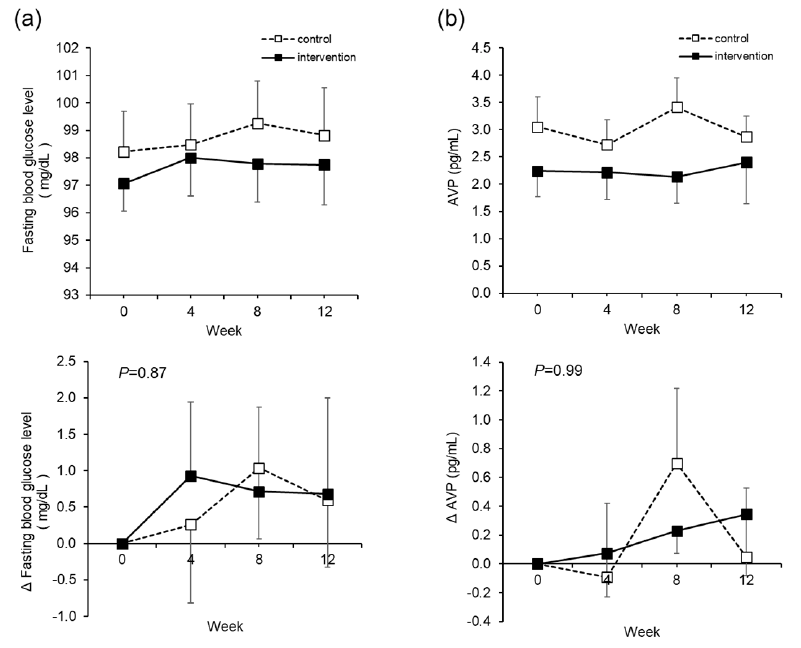
Figure 4. Fasting blood glucose level and arginine vasopressin (AVP). The actual level (upper) and changes (lower) in the fasting blood glucose level ( a ). The actual level (upper) and changes (lower) in AVP ( b ). The dotted line is the control group. The solid line is the intervention group. Mean ± SEM. The p value is the difference between the groups for the change from Week 0 to Week 12. Two-way analysis of variance was performed. * Paired t -test adjusted by the Bonferroni method was performed for intragroup comparisons from Week 0. There was no significant difference.